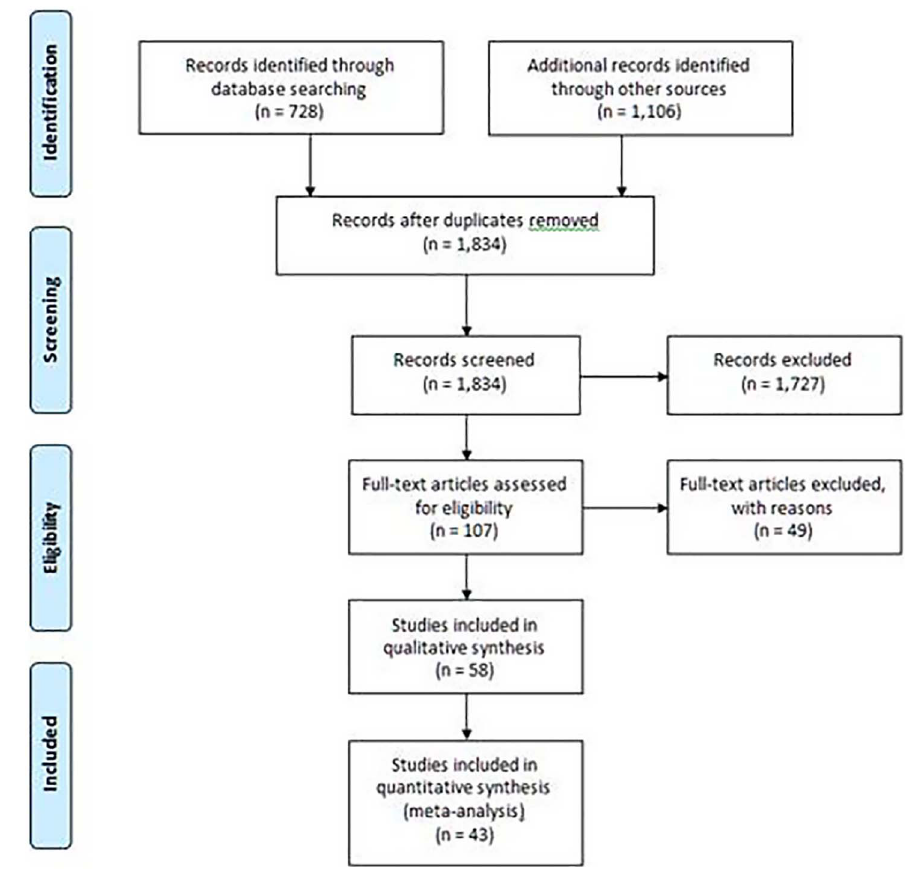
Figure 1. PRISMA Flow Diagram.